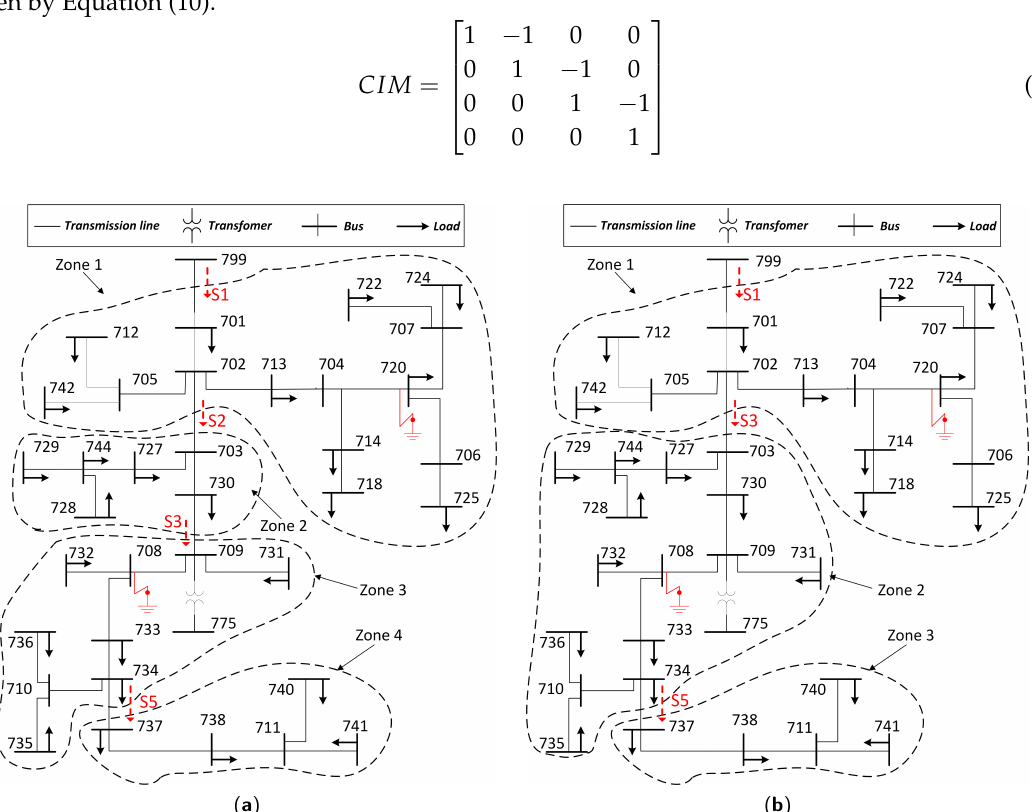
Figure 9. Reconfiguration of zones after the failure of Sensor 2 ( a ). Reconfiguration of zones after failure of sensors 2 and 4 ( b ). (Current measurements at the zone boundaries are marked in